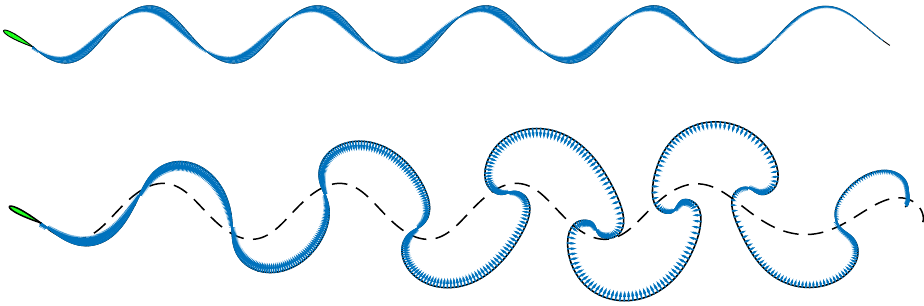
Figure 3. Comparison of the time-evolution of trailing vortex sheet for four periods of time. The simplified wake model (upper) and the free wake model (lower) are shown with the blue vectors denoting the potential jump. In the lower figure the simplified wake model (dashed line) is included for comparison purposes.